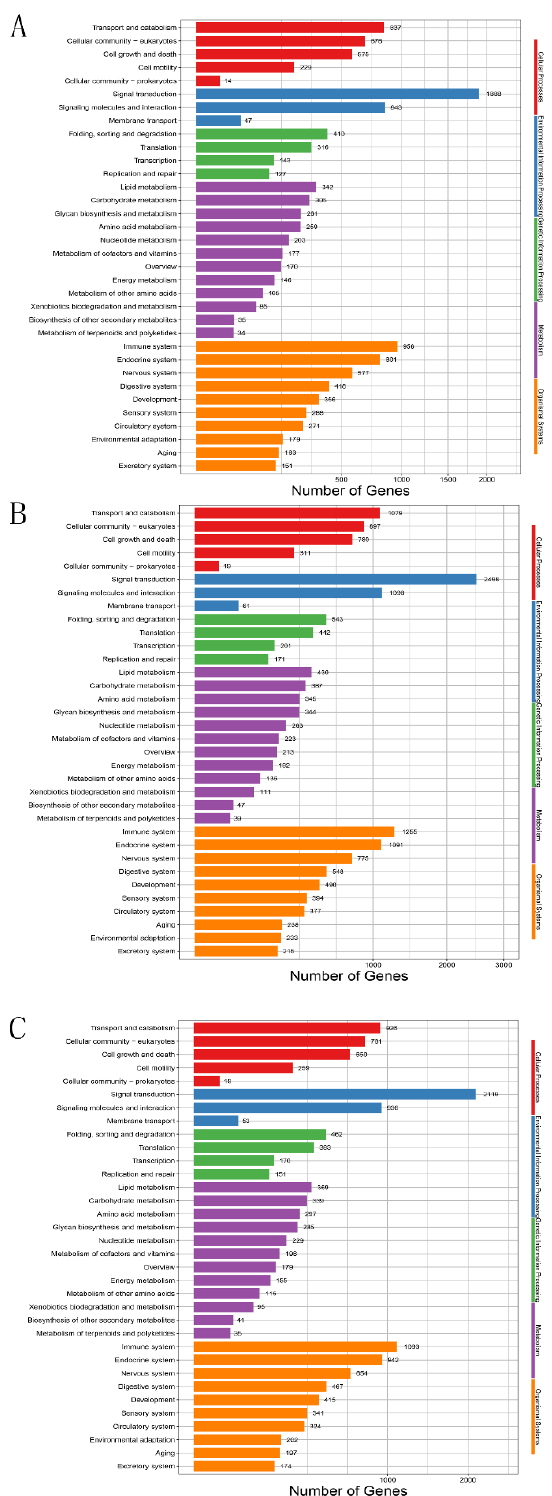
Figure 4. KEGG enrichment analysis of differentially expressed genes in different groups. ( A ) T0 vs. T1, ( B ) T0 vs. T2, ( C ) T0 vs. T3. The x-axis represents the number of genes and the y-axis